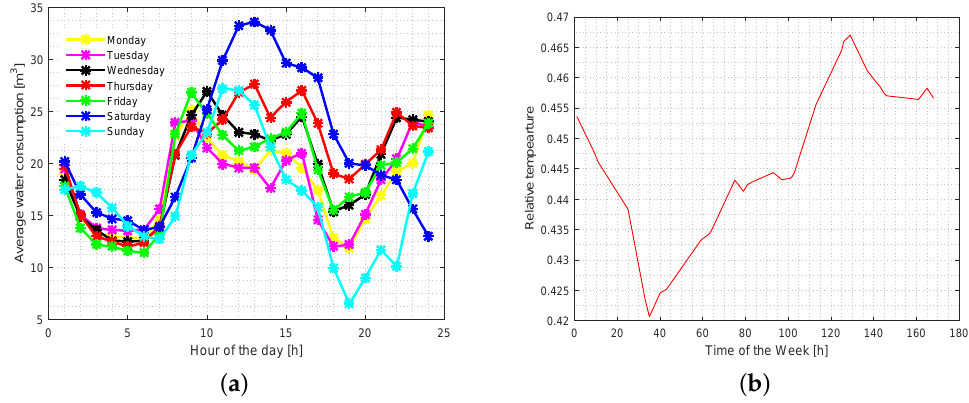
Figure 1. ( a ) Daily water demand profile and ( b ) Single exogenous variable “relative